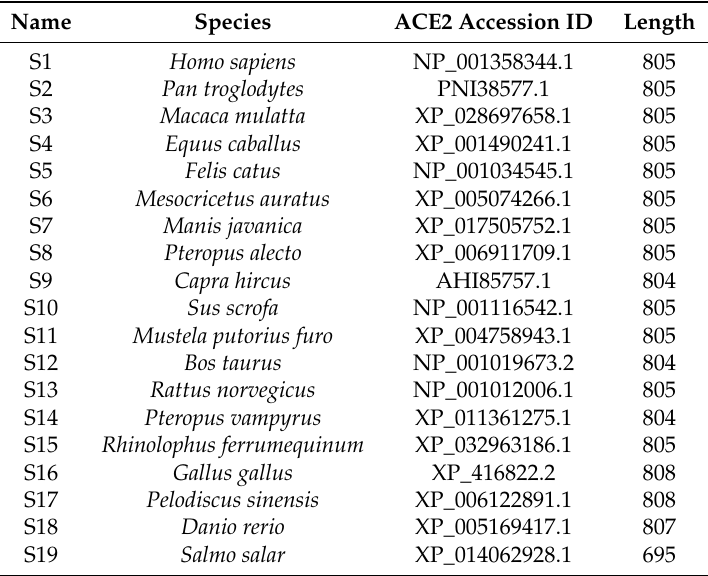
Table 2. Nineteen species and their associated ACE2